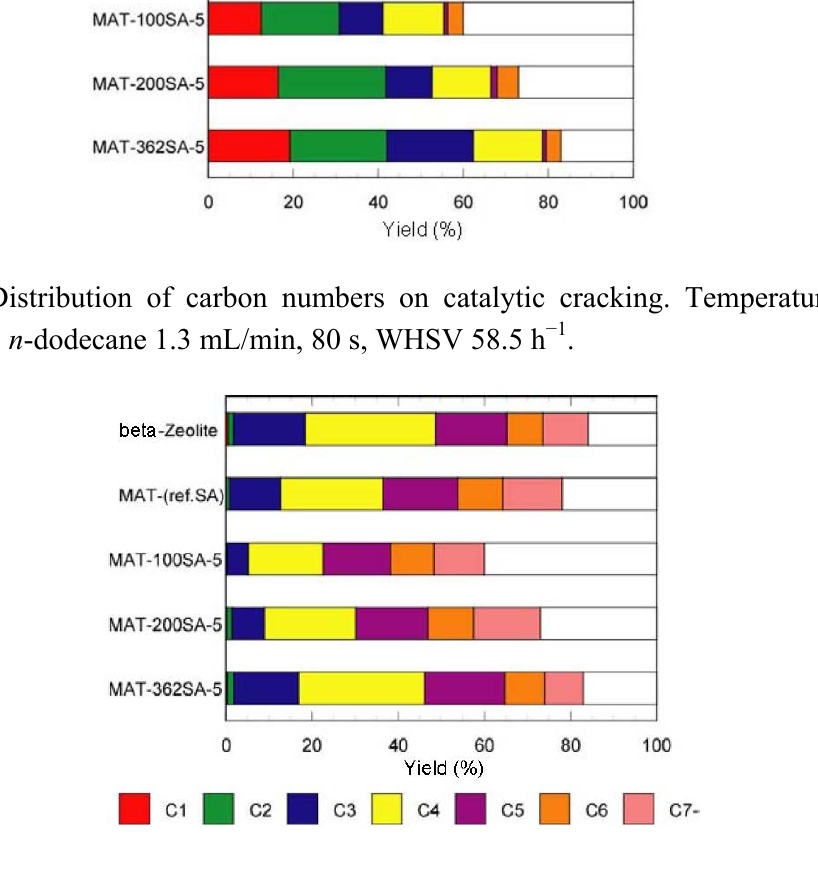
Figure 9. Effect of pore diameter on multi/single branch ratio. Except zeolite, values in the horizontal line represent peaks of BJH pore